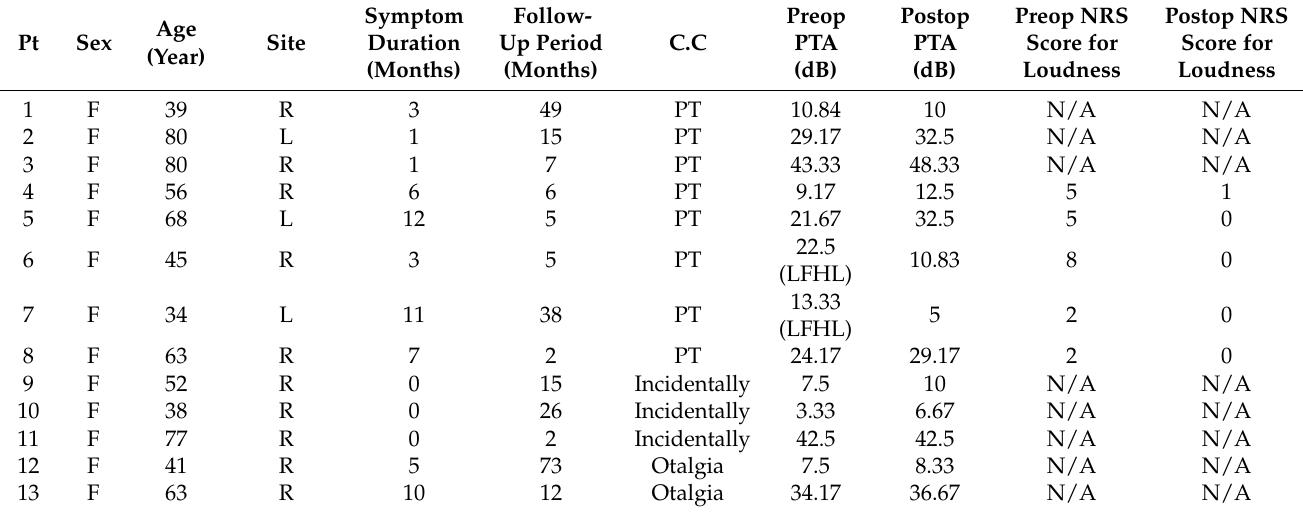
Table 1. Demographic and clinical data for all 13 patients with glomus tympanicum